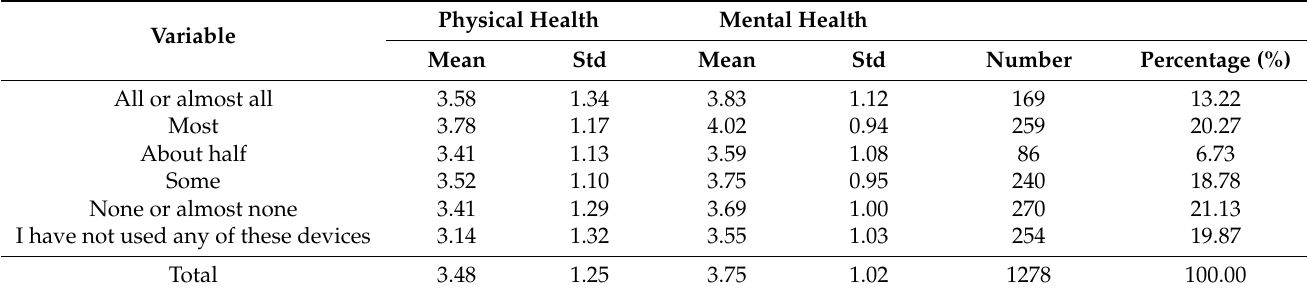
Table 2. Relationships between social media use and the health of older